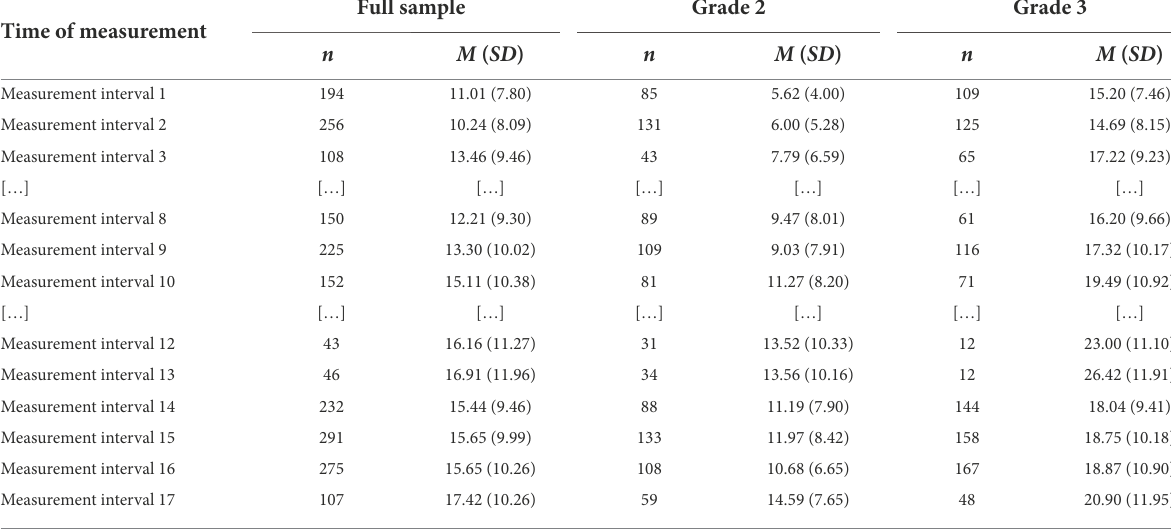
TABLE 4 Descriptive statistics of LPM scores for each measurement interval.